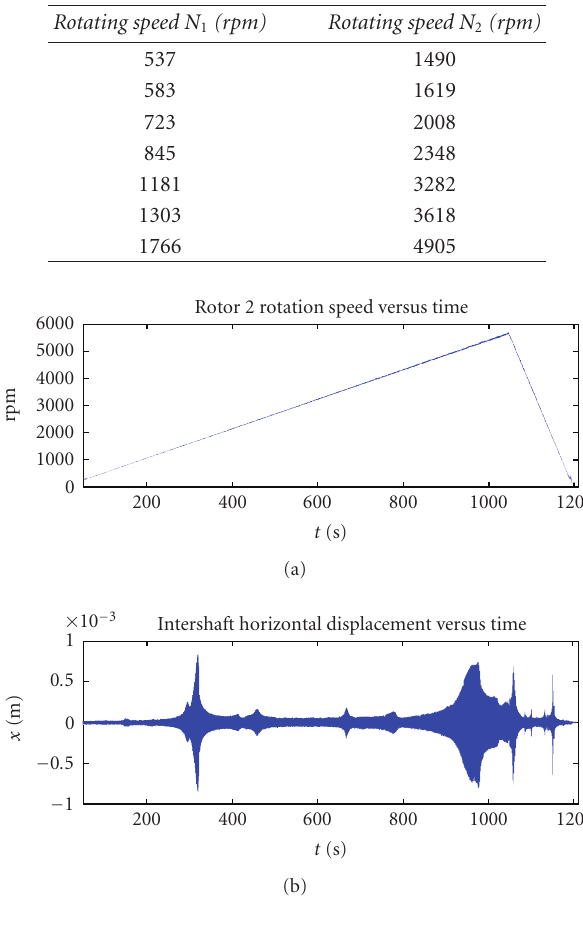
Table 2: Critical speeds with respect to rotor 2.